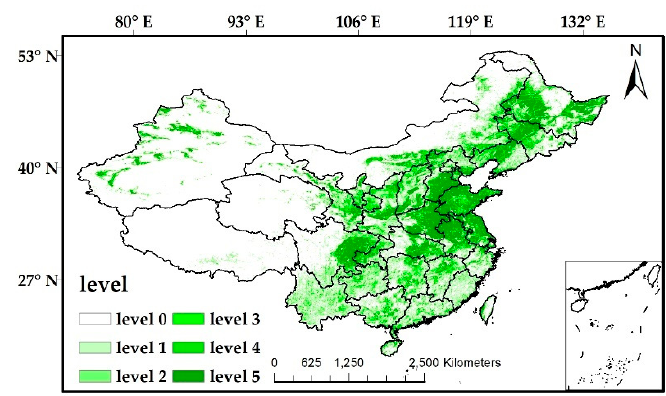
Figure 4. Cultivated land cover percentage distribution.